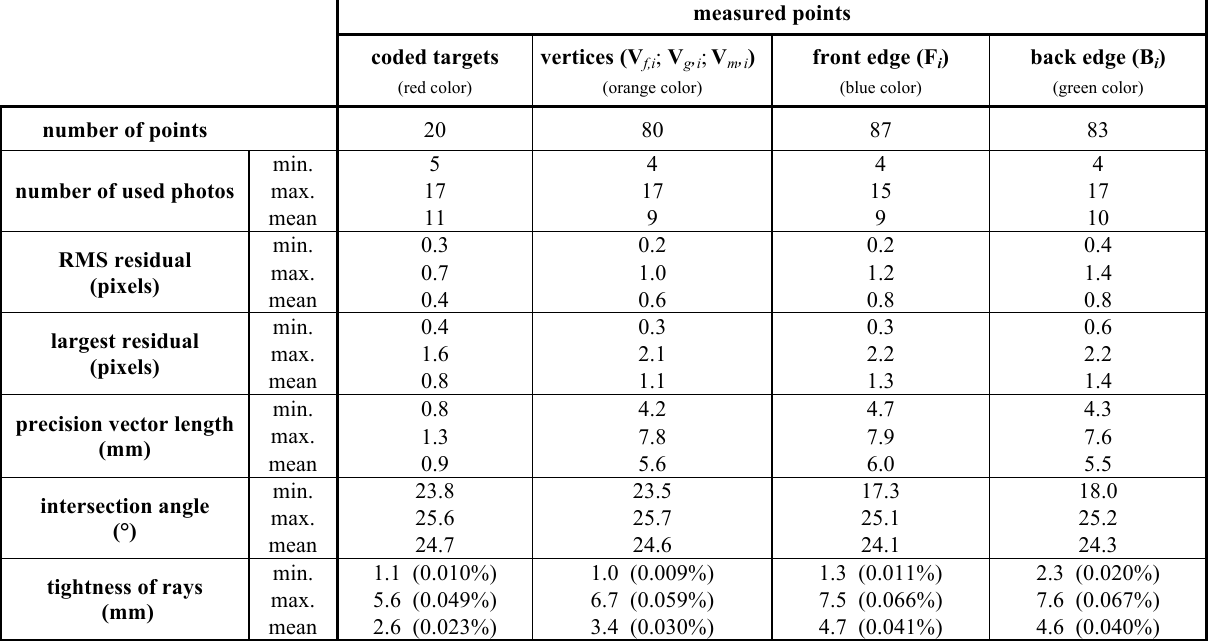
Tab. 1: Quality of measured